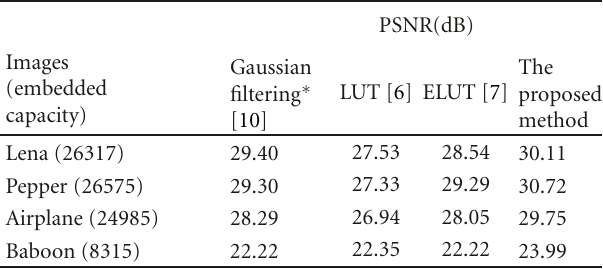
Table 2: The experiment result for four images using di ff erent methods.